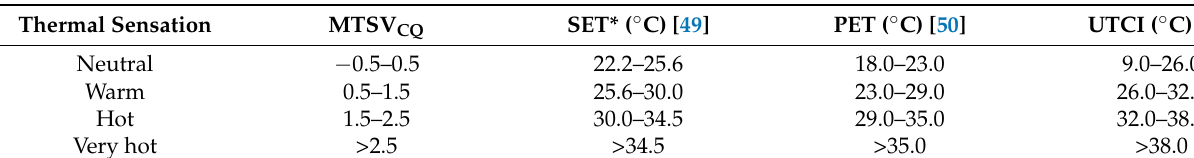
Table 5. Thermal sensation classification.